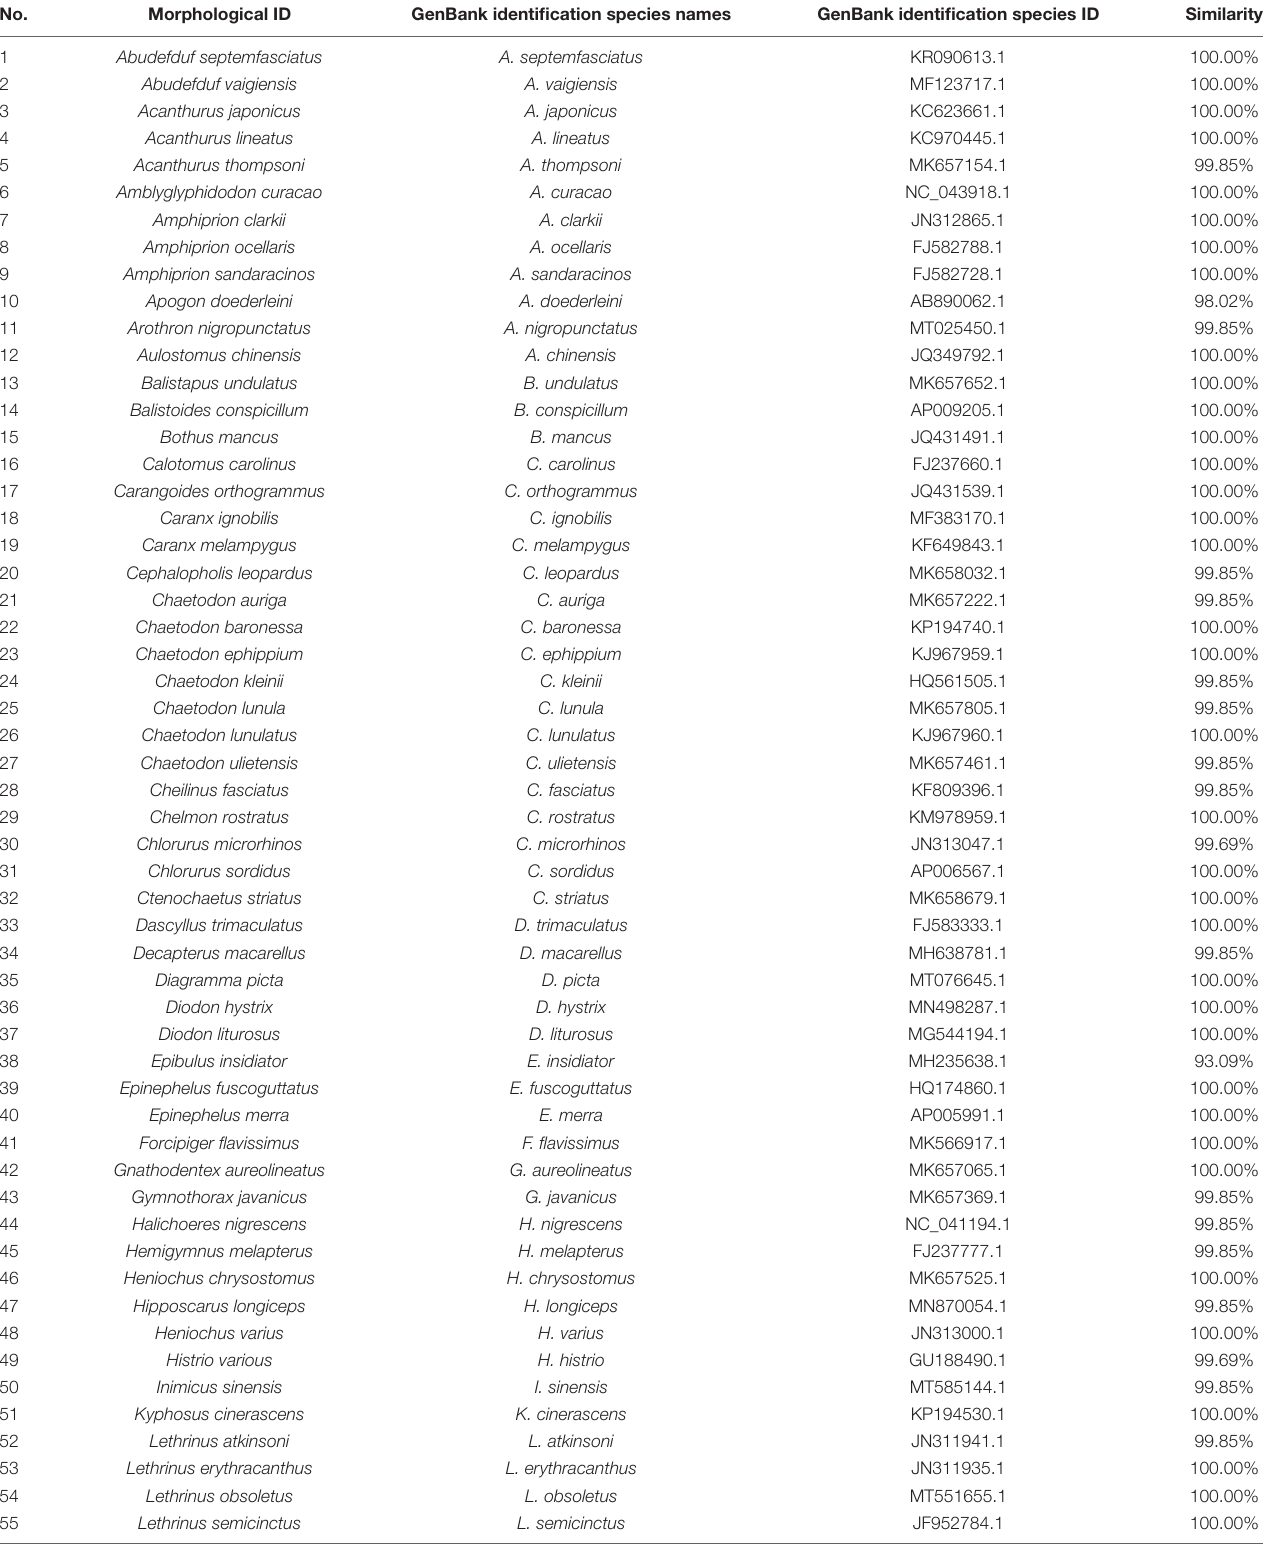
TABLE 1 | Species identification using morphology and DNA barcode.